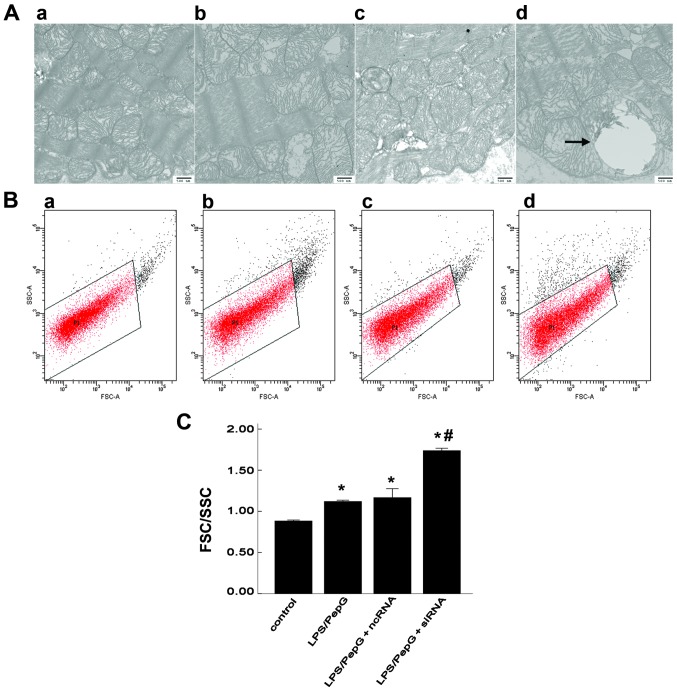
Effect of siRNA on mitochondrial morphology in H9C2 cells under septic conditions. (A) Scanning of H9C2 cell mitochondrial ultrastructure using a transmission electron microscope. Panel a, normal mitochondrial ultrastructure; panels b–d, swelling and vacuolization of mitochondria; panel d, megamitochondria (arrow); (original magnification, x30,000). (B) Flow cytometric determination of size [forward scatter (FSC)] and structure [side scatter (SSC)] of mitochondria in H9C2 cells. (A and B) Panels a–d, the control, LPS/PepG, LPS/PepG + negative control siRNA (ncRNA) and LPS/PepG + siRNA group, respectively (C) Quantitative evaluation of mitochondrial swelling by flow cytometry (FCM). The FSC/SSC ratio represents the degree of mitochondrial swelling. Values are expressed as the means ± SD. *P<0.05 vs. control group. #P<0.05 vs. lipopolysaccharide (LPS)/peptidoglycan G (PepG) group. n=3 per group.